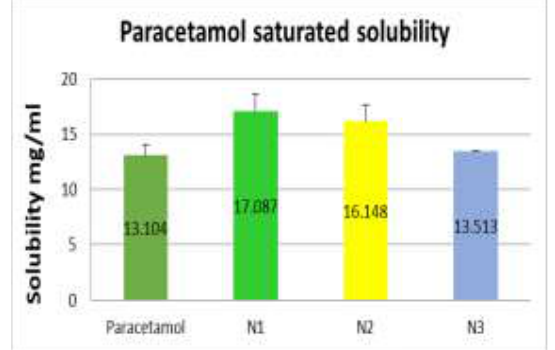
Figure 17. Solubility of pure paracetamol and its co-crystals N1, N2 and N3; All values are expressed as mean ±